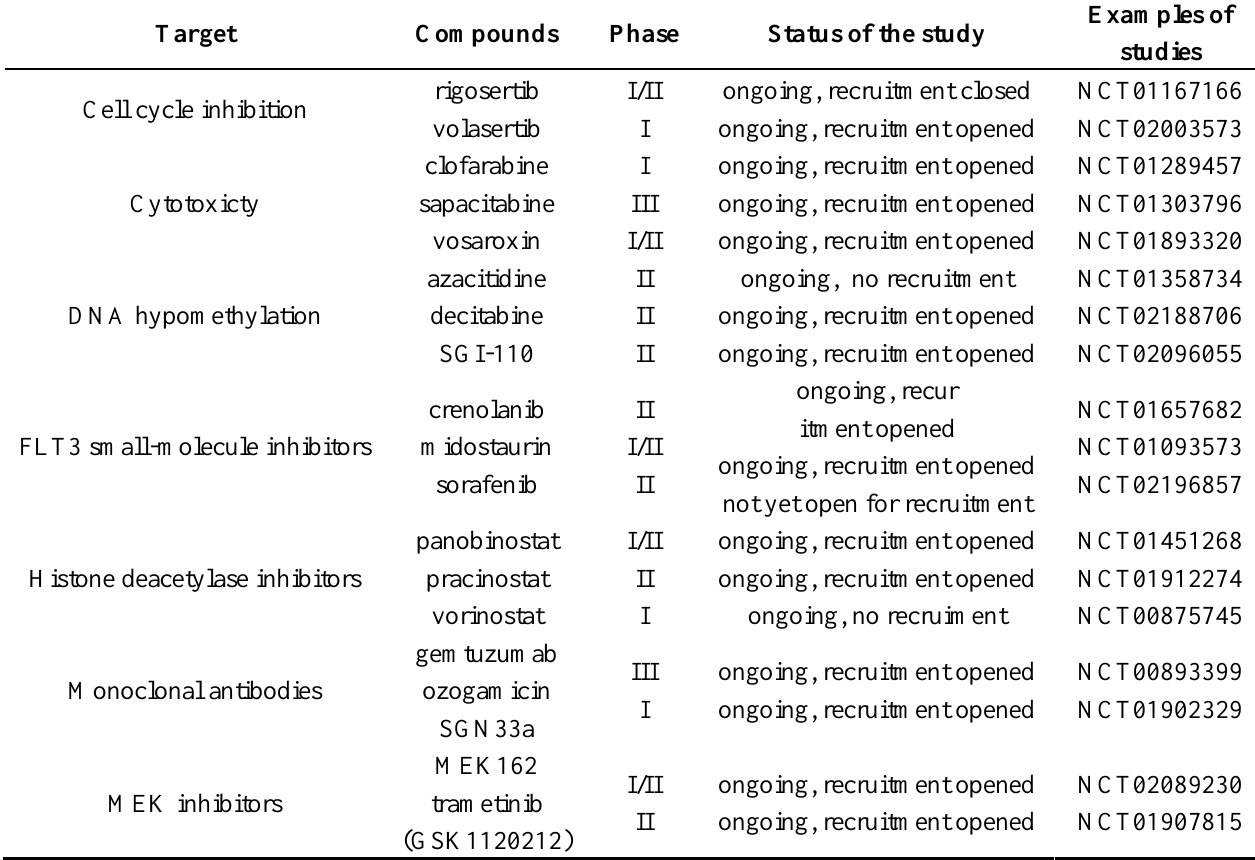
Table 2. New agents in AML clinical trials. The recent clinical trials of AML have focused on new cytotoxic drugs, cell cycle and histone deacetylase inhibitors, monoclonal antibodies, FLT3 and MEK kinase inhibitors or hypomethylating agents. These were conducted without